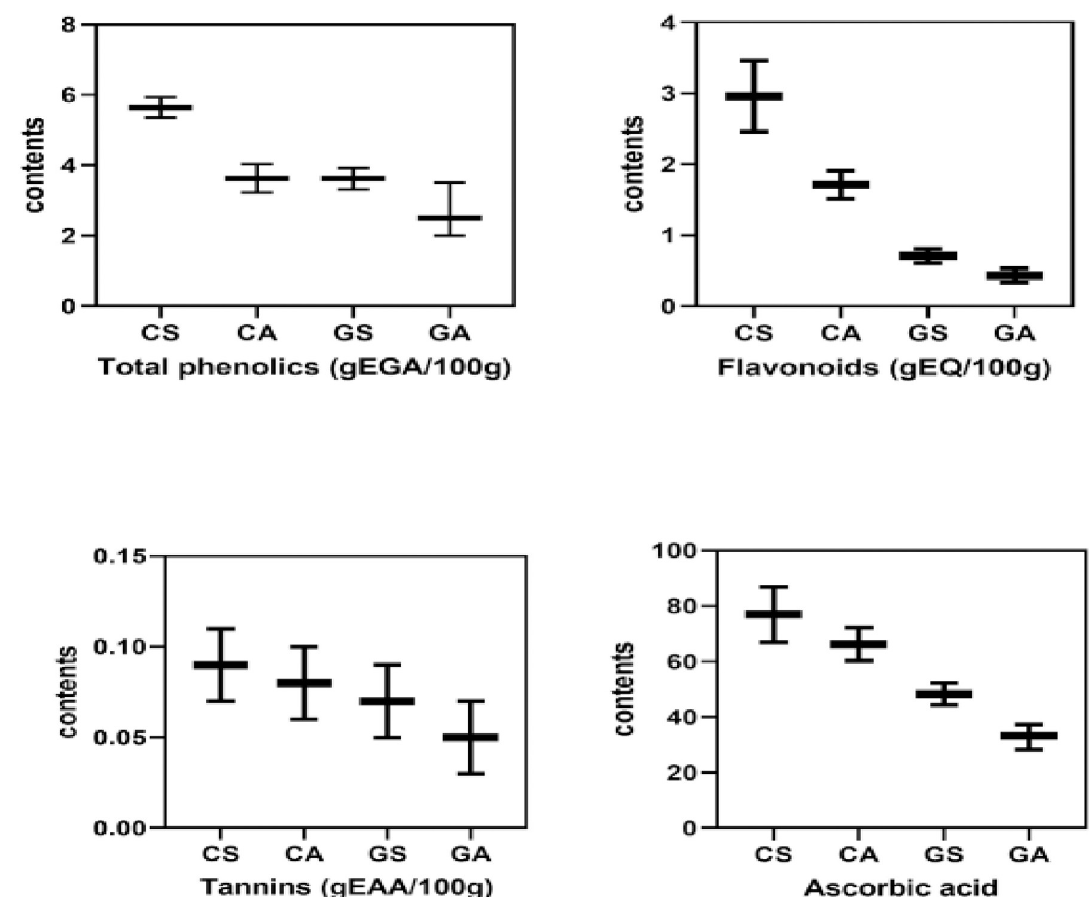
Fig 3. Comparative study of bioactive coumpounds